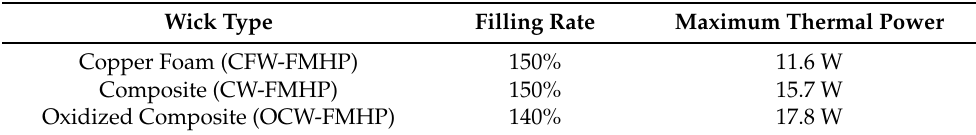
Table 1. Maximum thermal power of FMHP with different wick